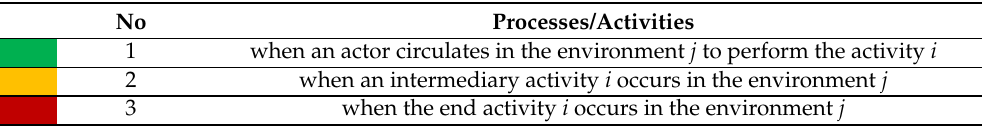
Table 1. Types of relationships for an activity carried out in an environment.